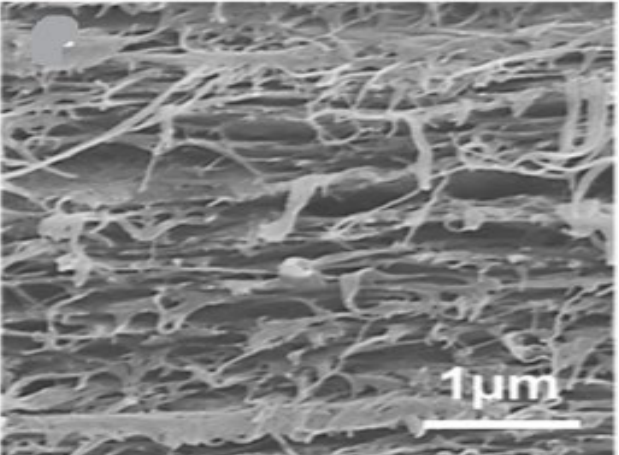
Figure 16. A cross-section of a pristine BNC membrane. Reprinted/adapted with permission from Figure 11. A cross-section of a pristine BNC membrane. Reprinted with permission from Ref. [155]. Ref. [155]. Copyright 2019 American Chemical